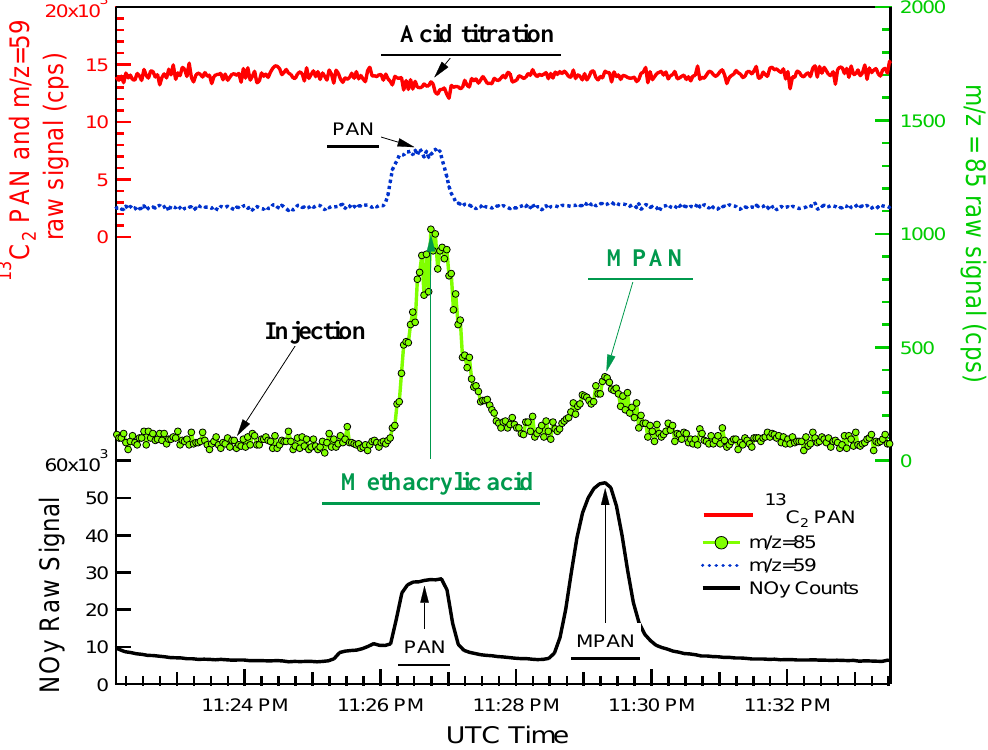
Fig. 10. MPAN as output from the prep-GC measured by the TD-CIMS and the NO y detector. The 13 C 2 PAN trace shows the titration effect of the proton transfer reaction between the 13 C 2 acetate ion and methacrylic acid. PBN to PAN ratio at the inlet of the TD-CIMS than inside the chamber. For the one case where we did a direct compar- ison of PnBN between the NCAR fast GC and the TD-CIMS sampling simultaneously downstream of the sampling valve, the difference was smaller. Since the NOy and TD-CIMS shared a transfer line, this result should be more reliable than the FTIR